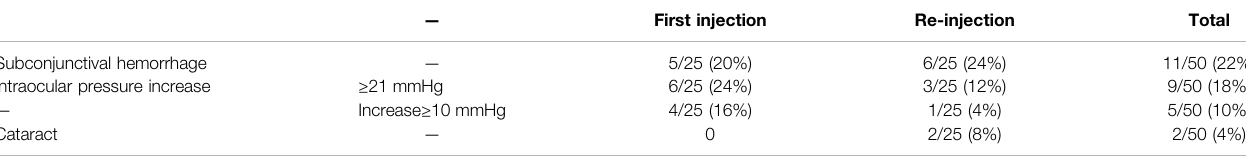
TABLE 3 | Adverse events of this study.